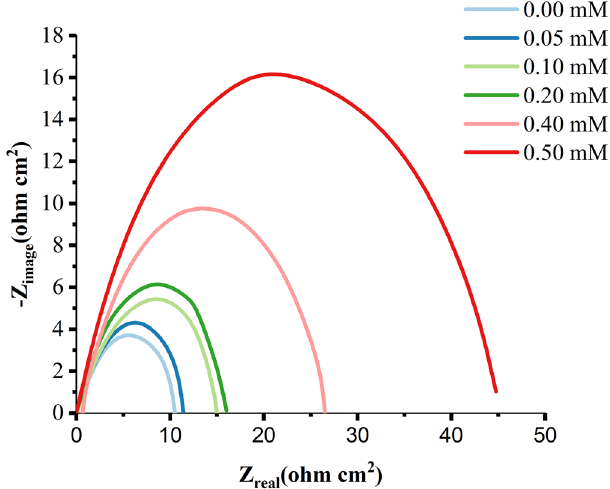
Figure 9. Nyquist plots for MS in 1.0 M HCl with various concentrations of nonanedihydrazide at 303 K.